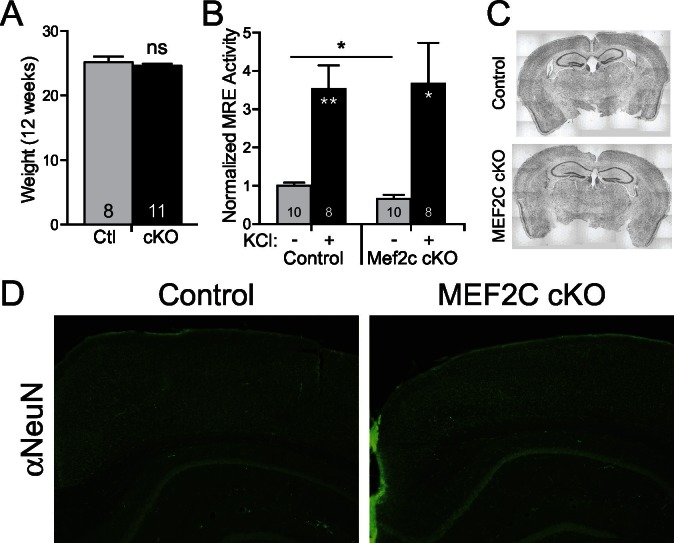
Neuronal characterization of Mef2c cKO mice.(A) There was no difference in body weight between Mef2c cKO mice and control littermates during behavioral testing (12 weeks). (B) Basal MEF2 transcriptional activity is reduced by ~40% in Mef2c cKO neuronal cultures, and neuronal depolarization with KCl (60 mM) promotes MEF2 activity in both control and Mef2c cKO cultures. Cortical cultures from control and Mef2c cKO animals were transfected with MEF2-response element (MRE)-Luciferase at DIV5, and activity was monitored at DIV7. (C) Nissl staining of adult control and Mef2c cKO brains show no gross morphological changes in the brain. (D) NeuN staining of adult control and Mef2c cKO brains reveal normal neuronal migration and layering. Data are represented as mean ± SEM. Statistical significance was determined by unpaired t-test. *p<0.05, **p<0.005, ns=not significant.